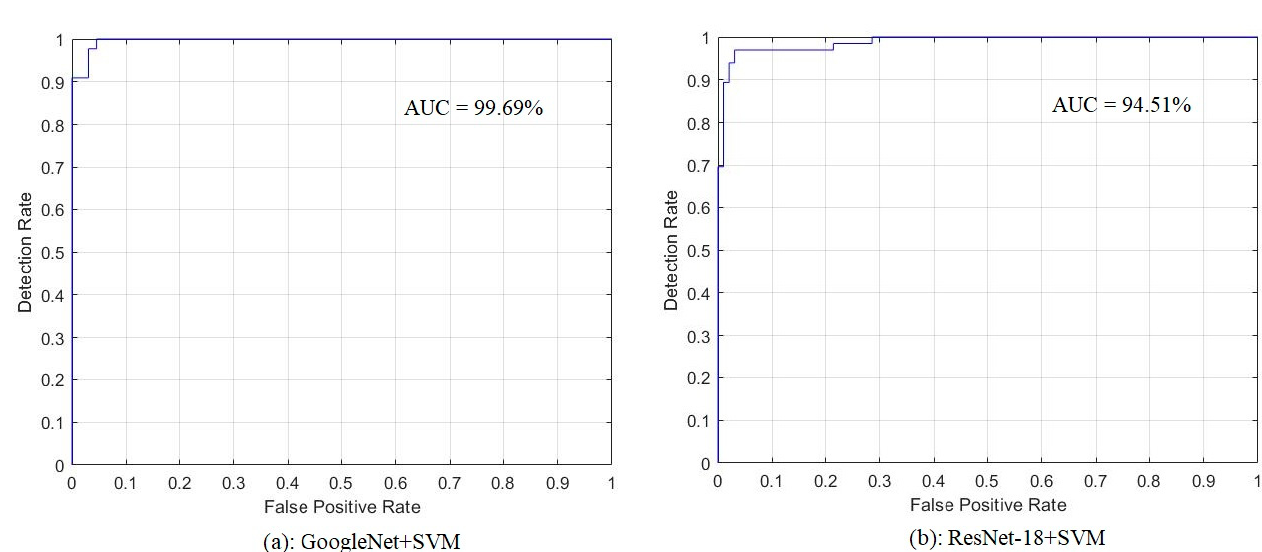
Figure 20. Area under the curve (AUC) of ASD dataset. ( a ) GoogleNet + SVM and ( b ) ResNet-18 + SVM.